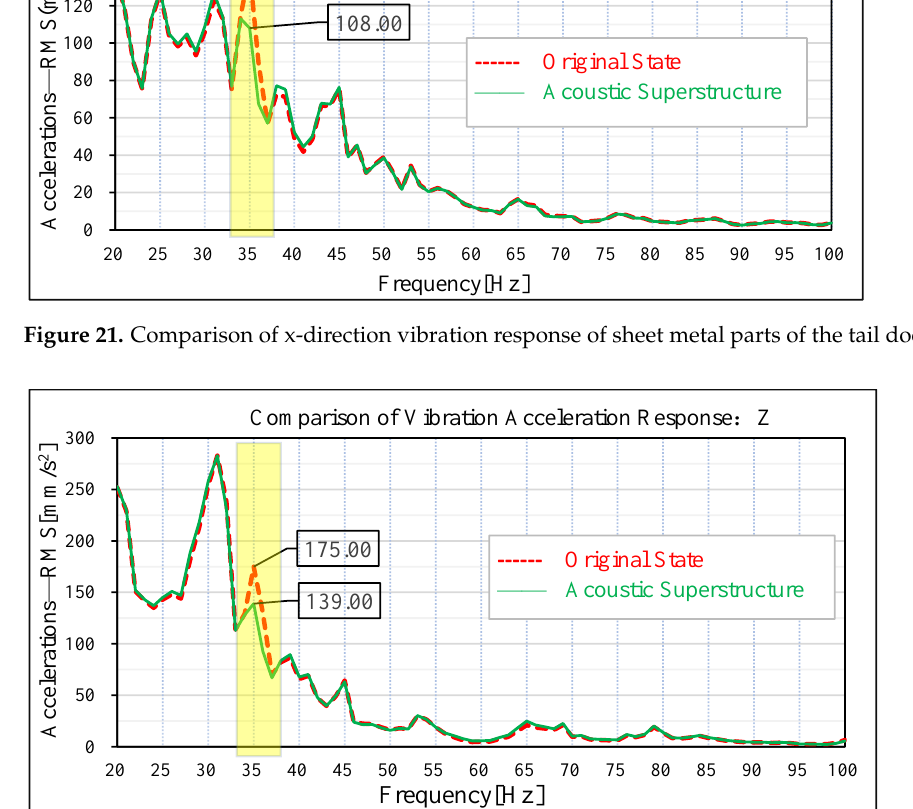
Figure 22. Comparison of z-direction vibration response of sheet metal parts of tail door. In the original state without an acoustic metamaterial attached, the sound pressure level at the driver’s right ear and the middle seat of the rear passenger’s seat has an obvious peak value at 35 Hz; the amplitude of the sound pressure level of the driver’s right ear at 35 Hz is 49.30 dB (A), and the amplitude of the sound pressure level of the passenger’s middle seat at 35 Hz is 50.50 dB (A). Under the condition of attached acoustic metamaterial,